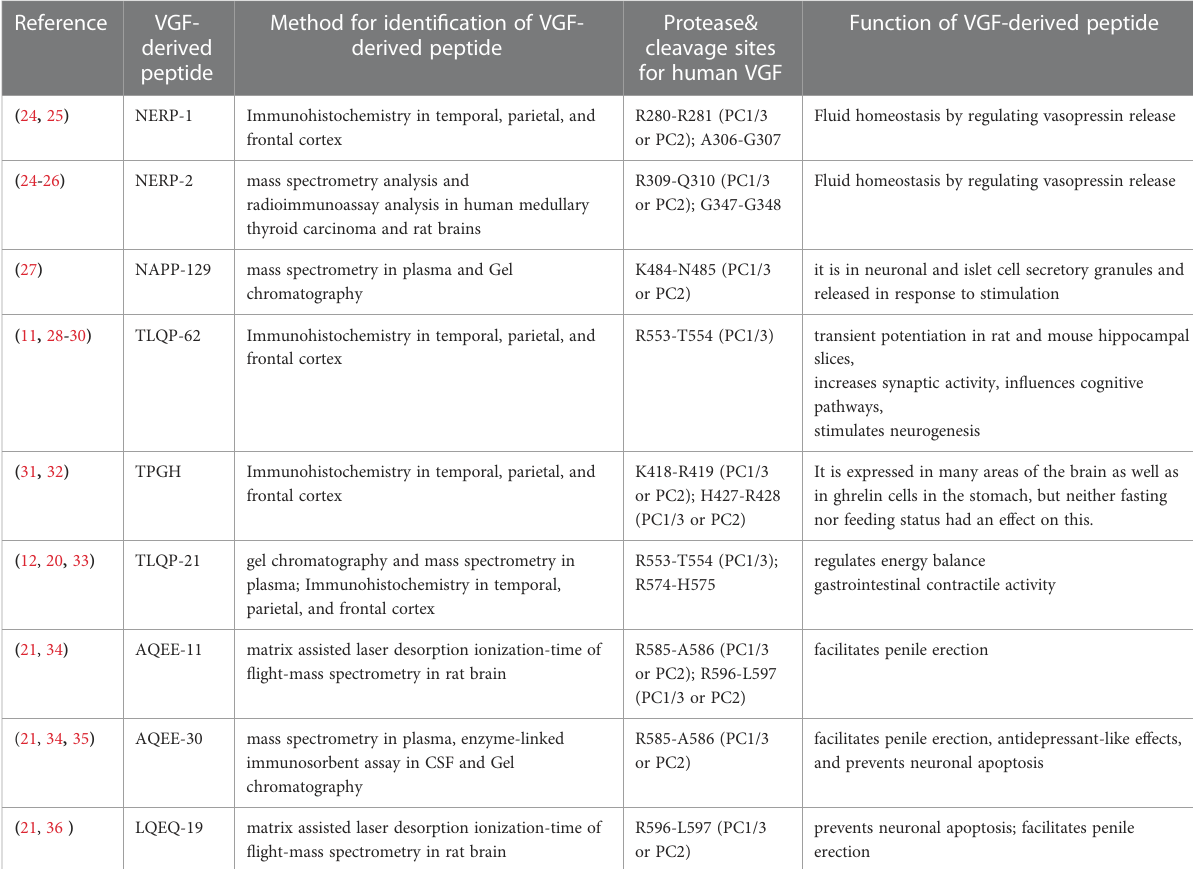
TABLE 1 Peptide identi fi cation method, cleavage sites, and function. Reference